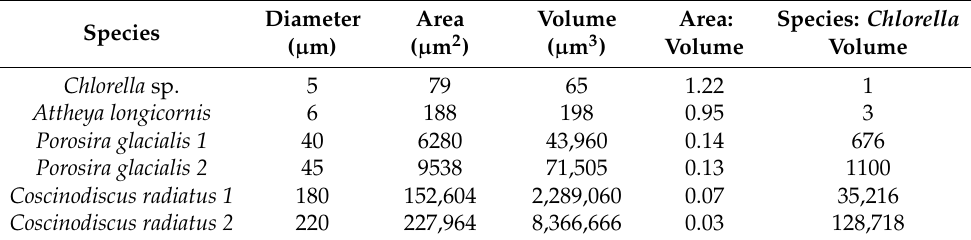
Table 1. Diameter, surface area and biovolume of the green microalgae Chlorella sp. and diatoms of different sizes ( Attheya longicornis and strains of Porosira glacialis and Coscinodicus radiatus ). Diatom sizes are from the authors’ own culture collections while the Chlorella sp. size and volume are from Martinez-Jeronimo and Gutierrez-Valdivia [63]. Other volumes are calculated from Menden-Deuer and Lessard